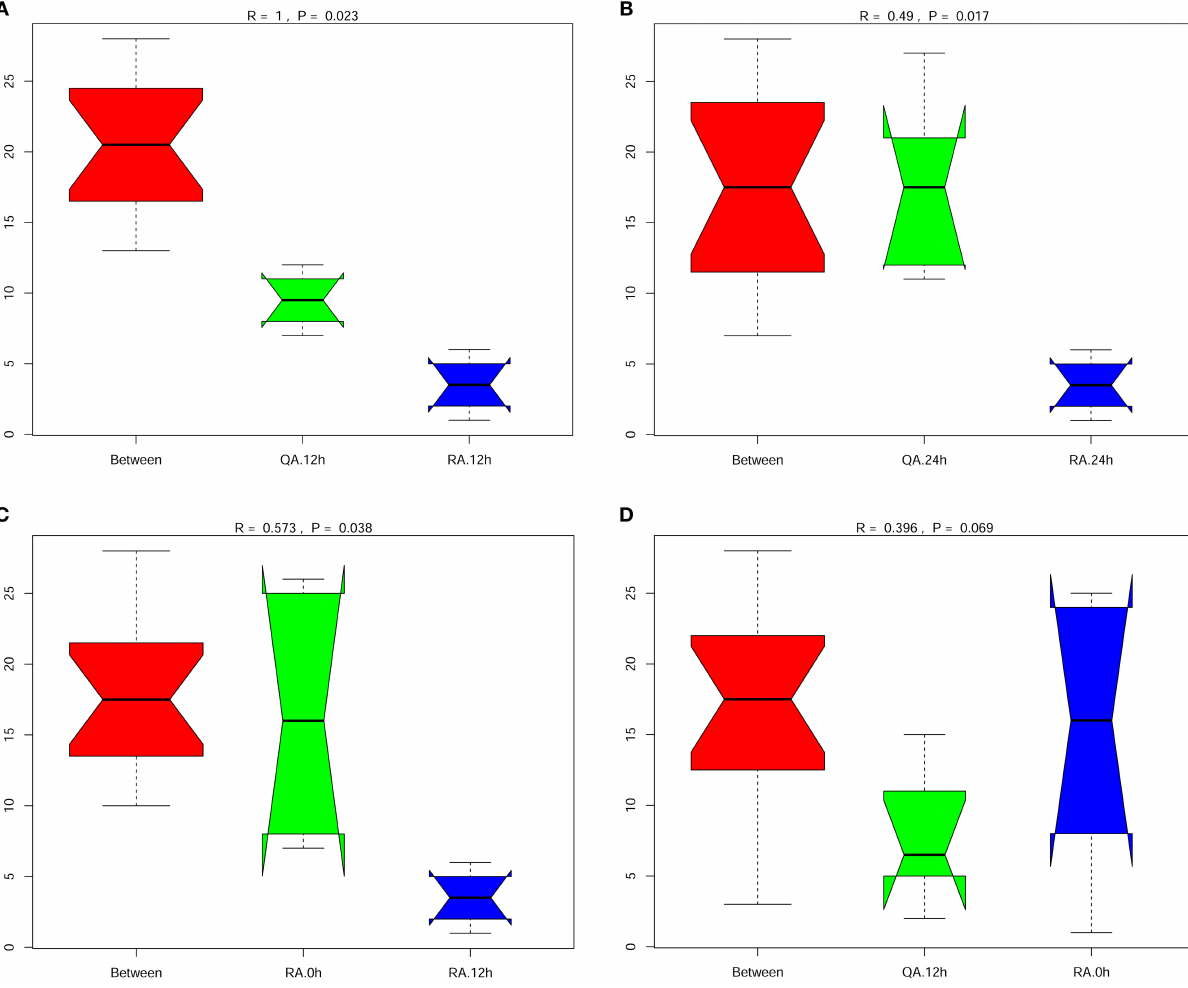
FIGURE 5 | Significant difference between the group oral with YM001 and the group fed with HN016. (A) The differences between group R (YM001) and group Q (HN016) at 12h by Anosim analysis. (B) The differences between group R (YM001) and group Q (HN016) at 24h. (C) The differences of group R (YM001) between 12h and 24h. (D) The differences of group Q (HN016) between 12 and 24h. R -value is between ( − 1, 1) and R -value is > 0, indicating significant difference between groups. R -value is < 0, indicating that the difference in the group is greater than that between groups. The credibility of statistical analysis is expressed in p -value, and P < 0.05 indicates that the statistics are